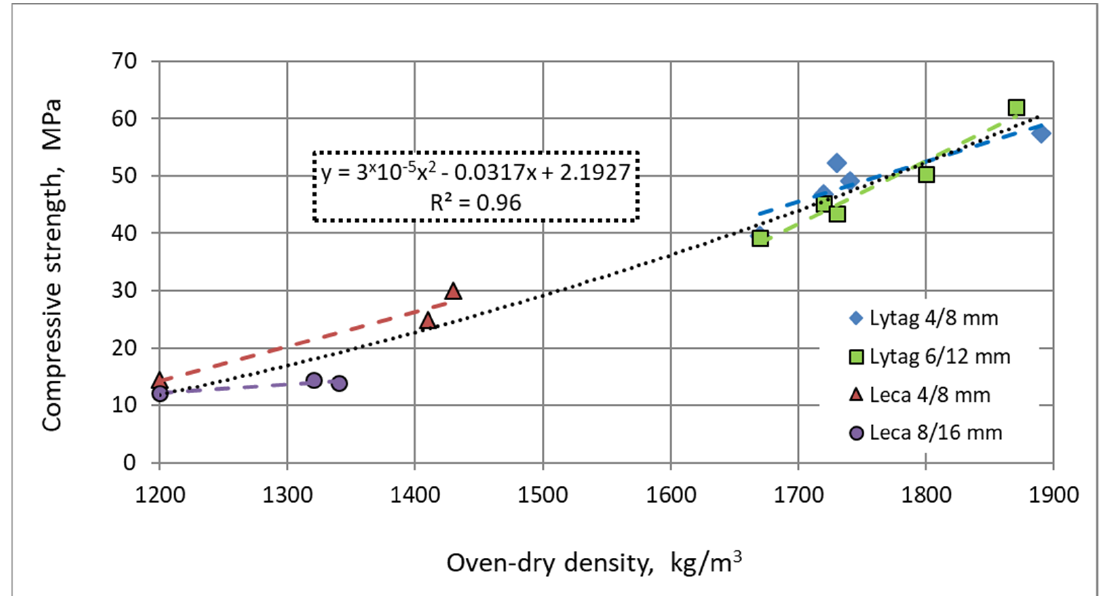
Figure 12 . Relationship between mean oven-dry density of tested concretes and their mean compres- sive strength.